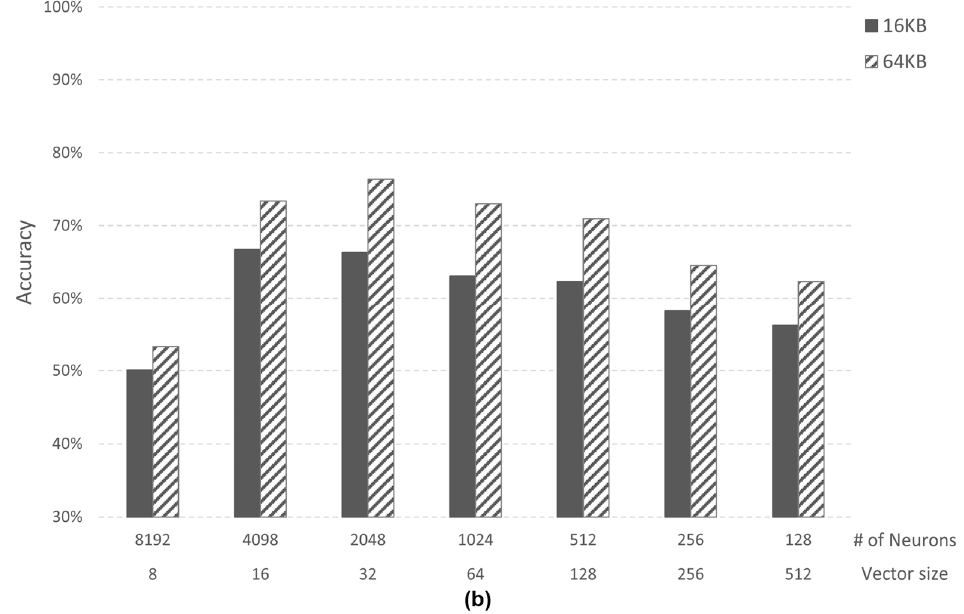
Figure 10. ( a ) Accuracy comparison in Case 1; ( b ) Accuracy comparison in Case 2-2.